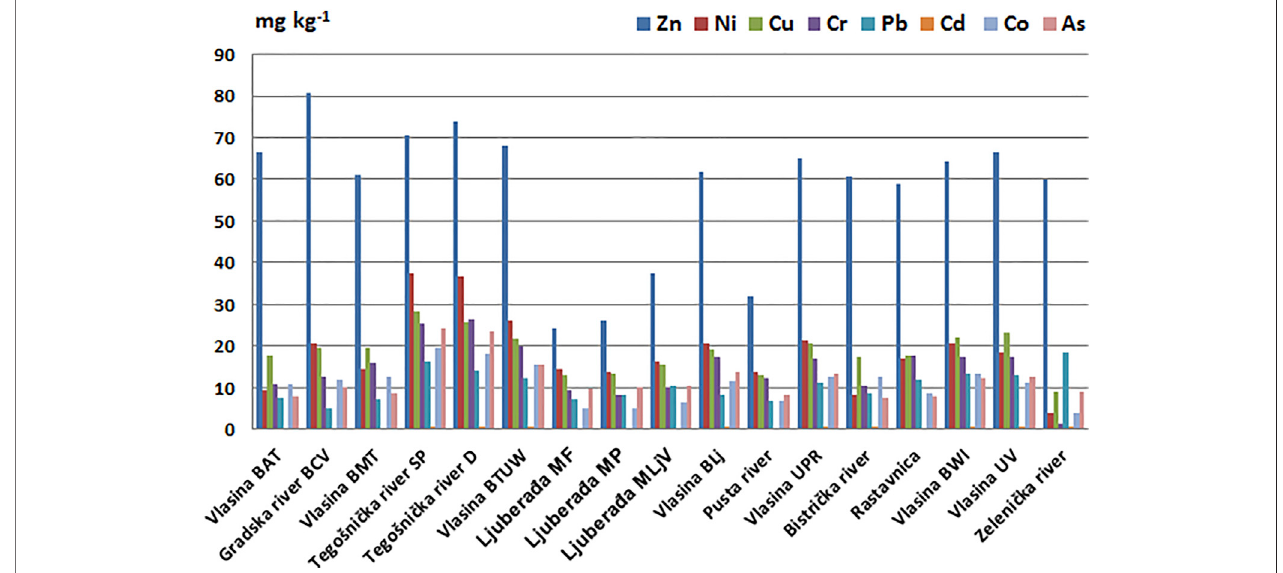
FIGURE 2 | Content of studied elements (Zn, Ni, Cu, Cr, Pb, Cd, Co, and As) in sediment.